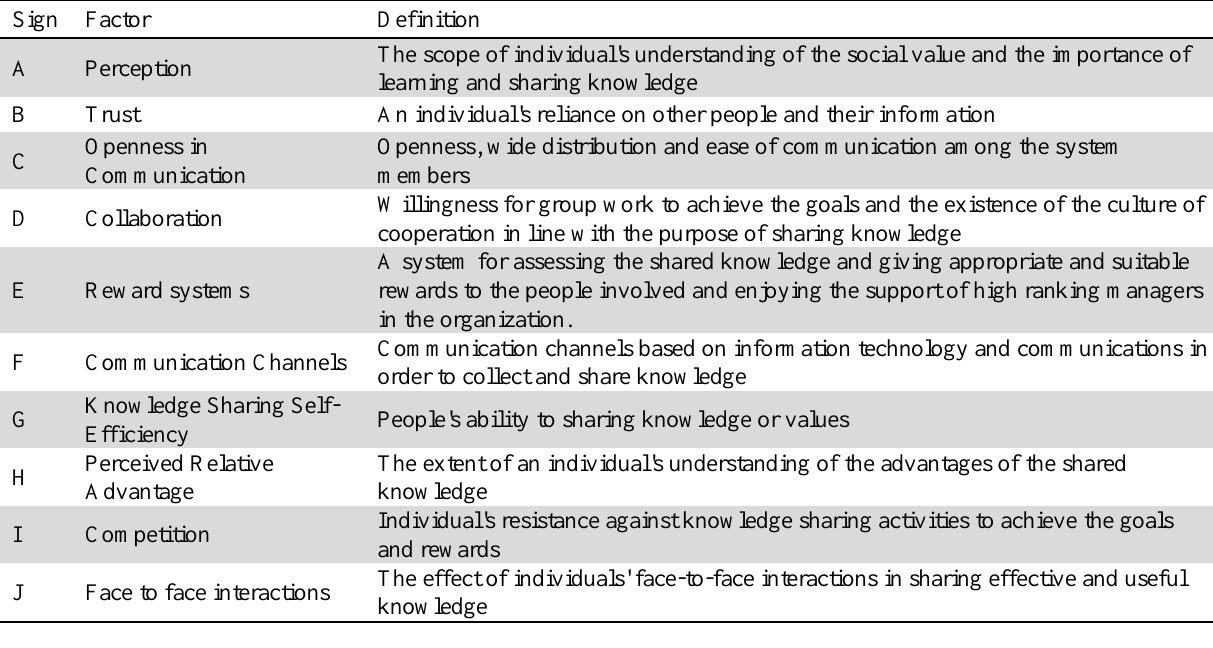
Indices for sharing knowledge and their definitions (Manyan & Mira, 2011)